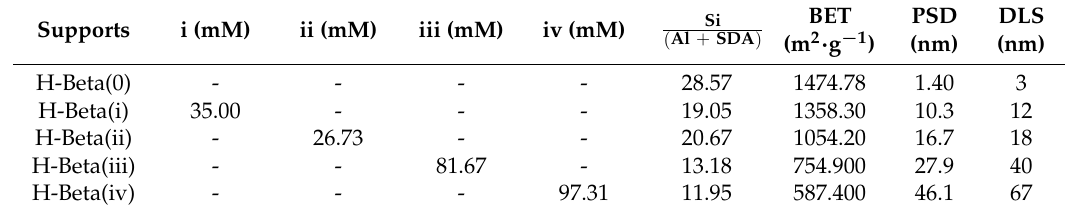
Table 1. Textural properties and optimum amount of Si/(Al + SDA) for different Beta-based catalysts. SDA: structure direct agents; BET: brunauer–emmett–teller, PSD: pore size distribution; DLS: dynamic light scattering.